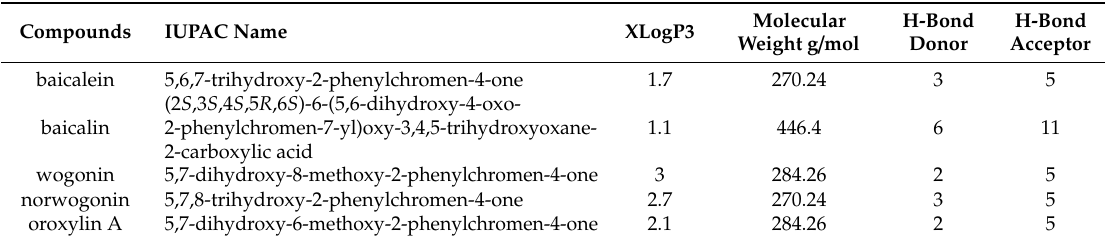
Table 1. The International Union of Pure and Applied Chemistry (IUPAC) name, hydrophobicity (XLogP3), molecular weight, hydrogen bond donor count, and hydrogen bond acceptor count of